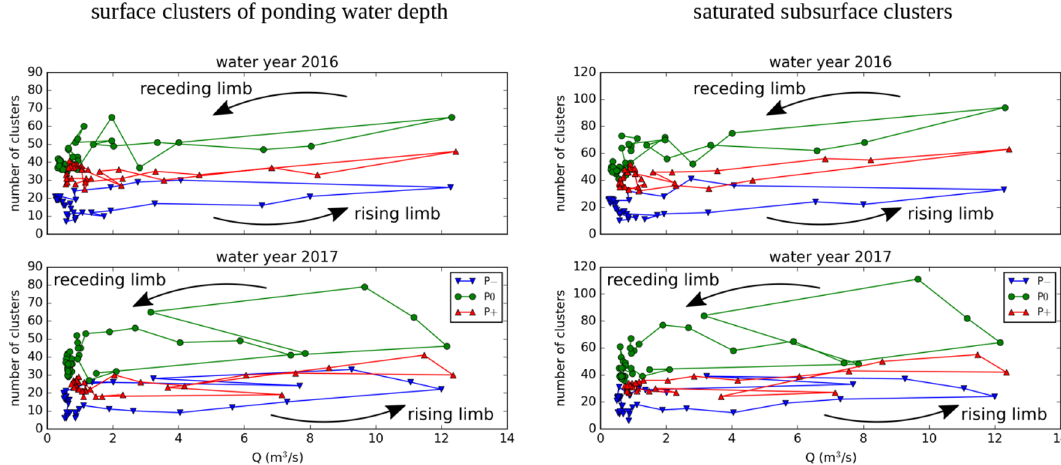
Figure 6. Relationship between number of disconnected wet clusters and discharge at the outlet for both simulated water years. Left: surface clusters of ponding water depth, right: saturated subsurface